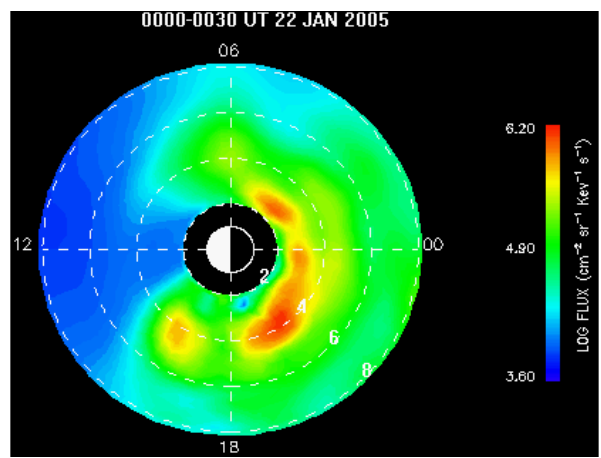
Fig. 10. The final equatorial ion distribution contour for pitch angle 90 ◦ , displayed in the same format used in Fig. 7. Figure 10.